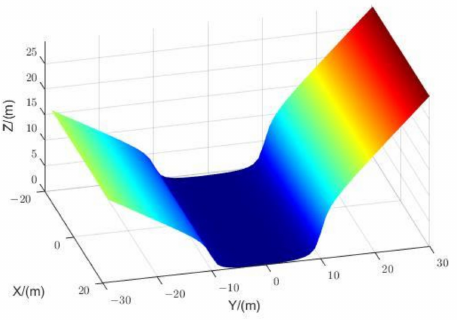
Figure 2. Sketch map of composite plate derived by weighted function.